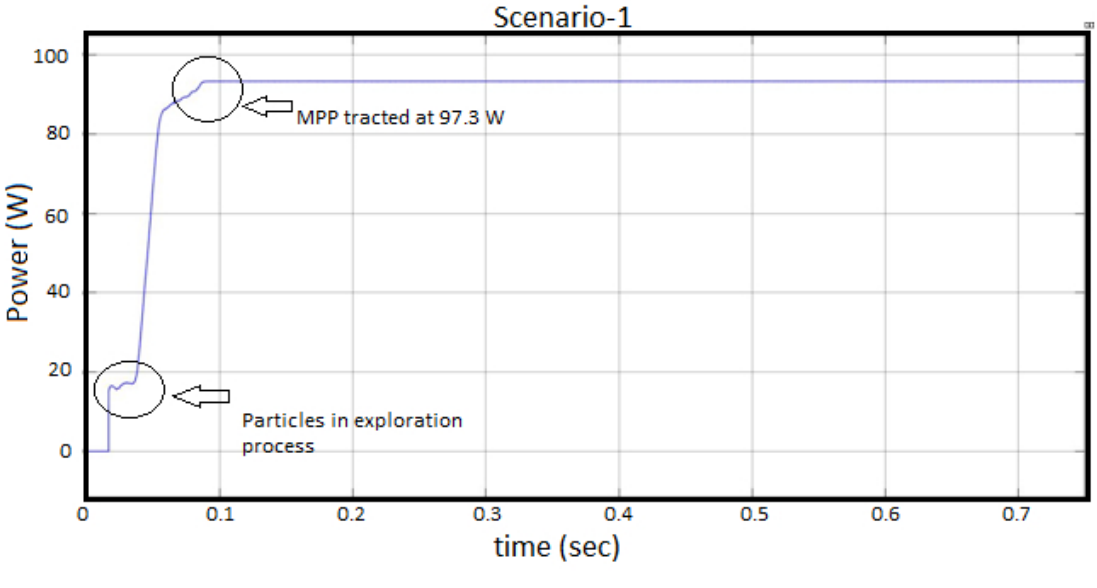
Figure 6. Performance of ICPSO under